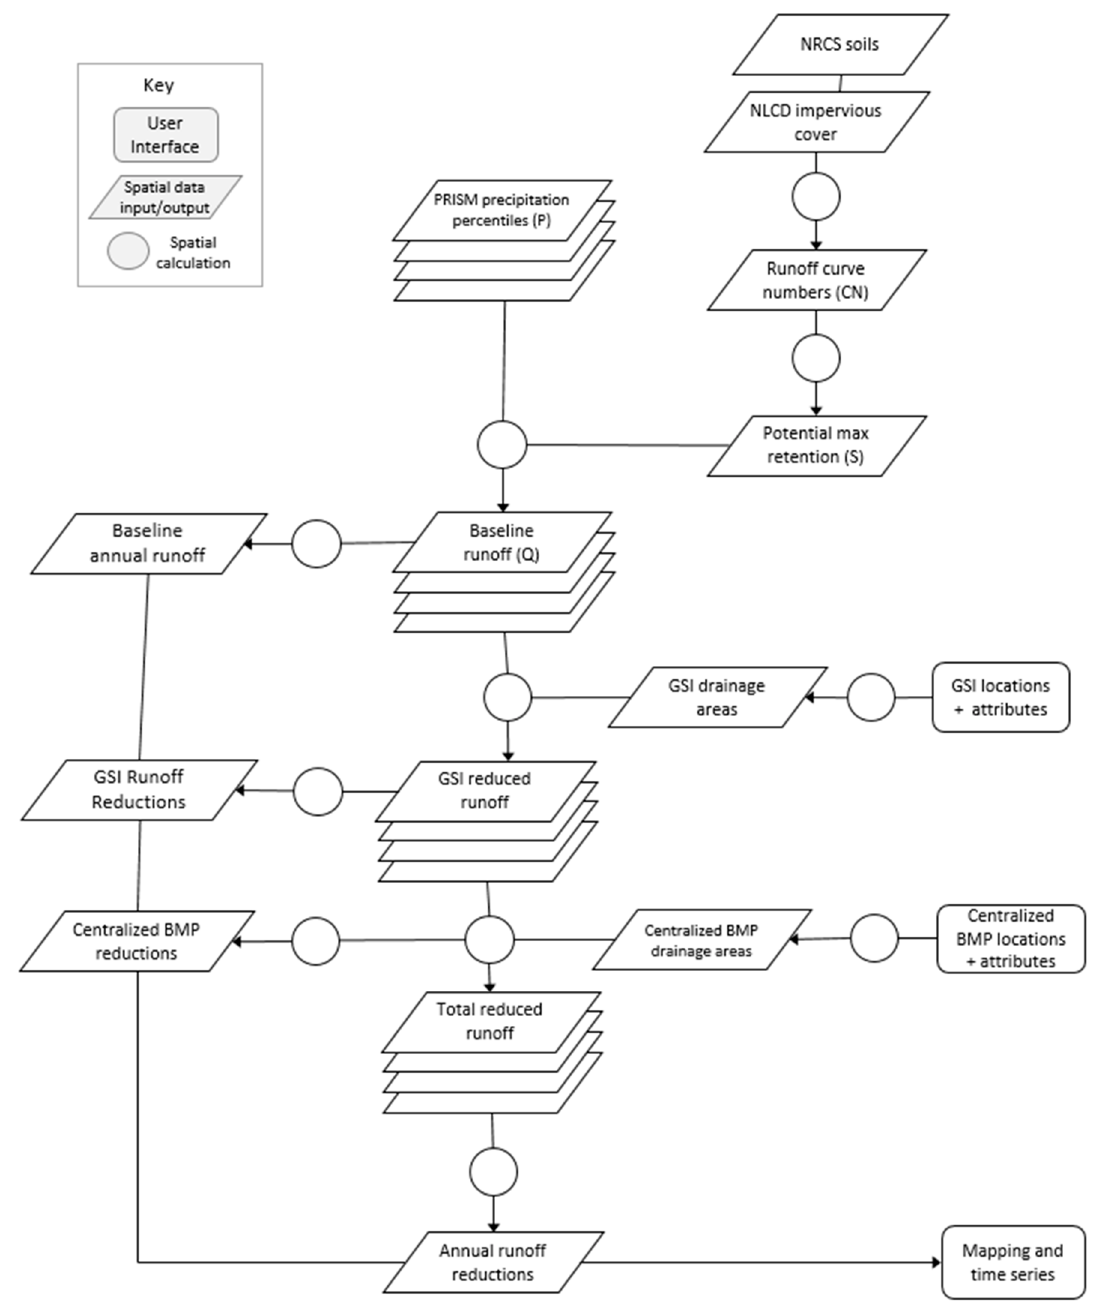
Figure 1. Structural overview for the grid based swTELR model with raster processing workflow. Green Stormwater Infrastructure (GSI) elements are described in this study and centralized treatment algorithms were reported in Beck et al., 2017 [31].